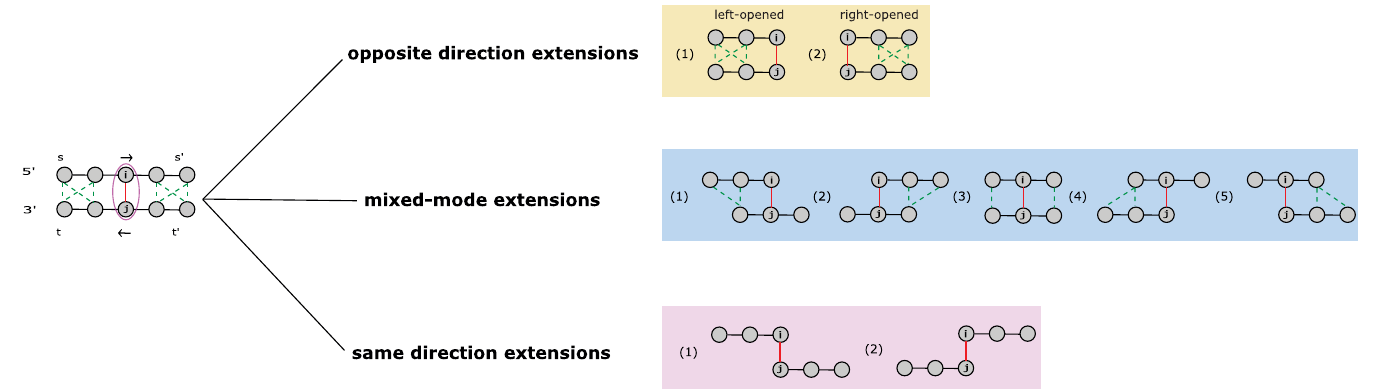
Fig 2. Definition and classification of EKSes. As displayed, there are three categories of EKS: opposite-direction extensions (right-opened and left-opened), mixed- mode extensions and same-direction extensions. Black edges represent backbone bonds, red edges represent base pair interaction between i and j, green dashed edges represent possible base pair interactions.